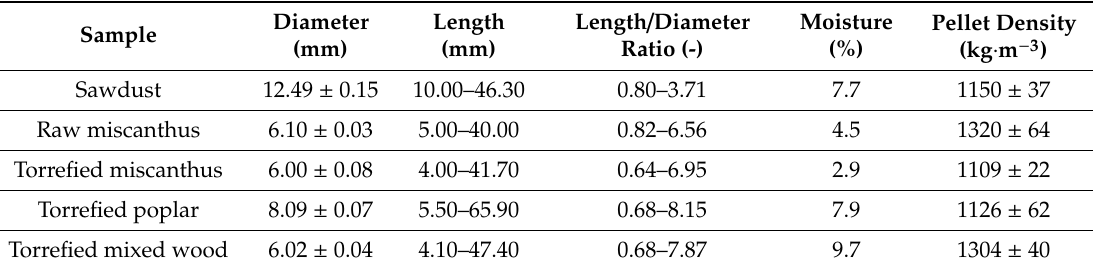
Table 1. Properties of the materials used in this study (pellet diameter and pellet density are the mean of 5 repetitions and the ± show the standard